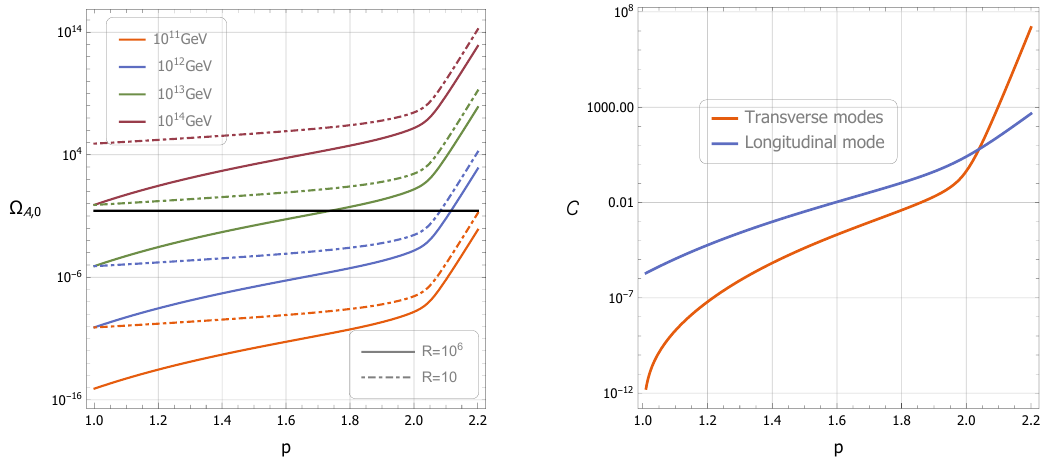
Figure 3 . Left: present energy density of dark photons given by eq. (4.1) as a function of p for R = 10 (dashed-dotted curves) and R = 10 6 (solid curves) for different reheat temperatures with N = 50 . The solid black horizontal line represents the observed dark matter density Ω D = 0 . 27 . Right: comparison of the contributions of the transverse and longitudinal modes to the energy density for R = 10 6